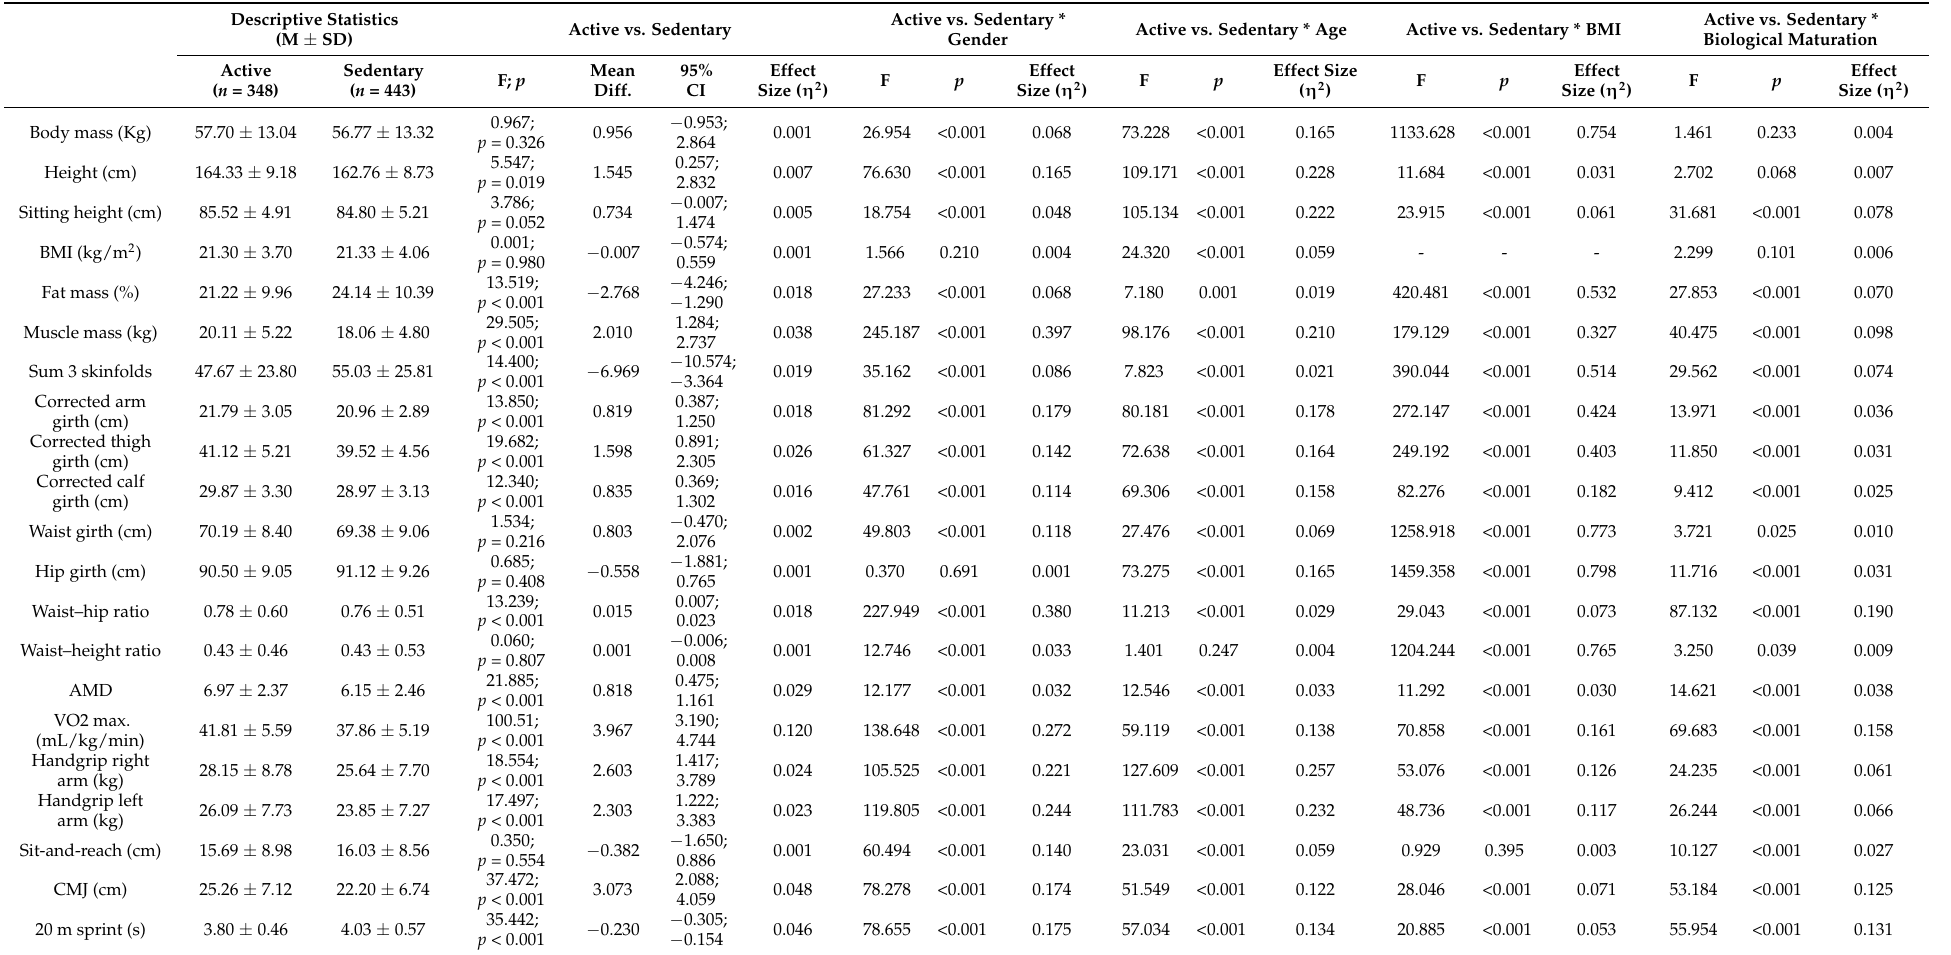
Table 1. Differences in anthropometric, nutritional habits, and physical fitness, between active and sedentary